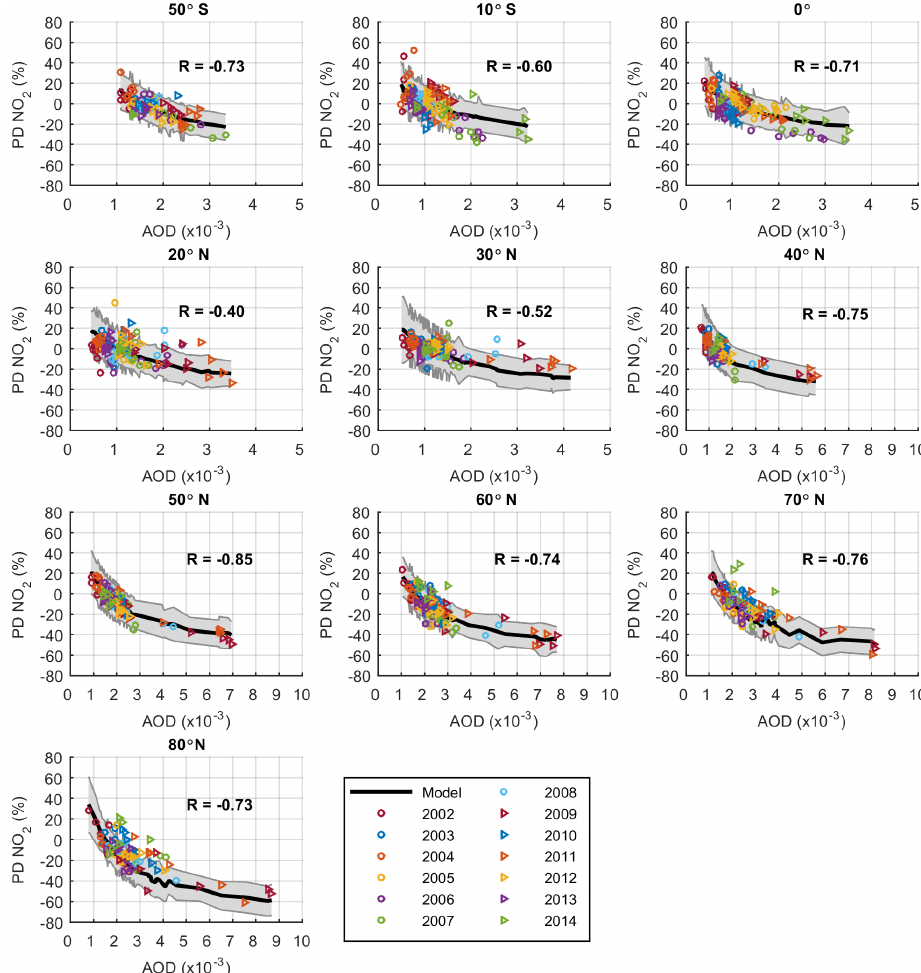
Figure 5. Scatter plots of OSIRIS AOD versus OSIRIS NO 2 percent difference in VCD relative to background levels for various latitudes, with R given in the plot. The legend shows the measurement years. Modeled values are shown with black lines, and the shaded region represents uncertainties in aerosol extinction to aerosol surface area conversions and model input parameters, as described in Sect. 2.3. The p values for R in all panels are less than 1 × 10 − 5 . Note that the scale of the x axis varies between panels so that the data can be seen more